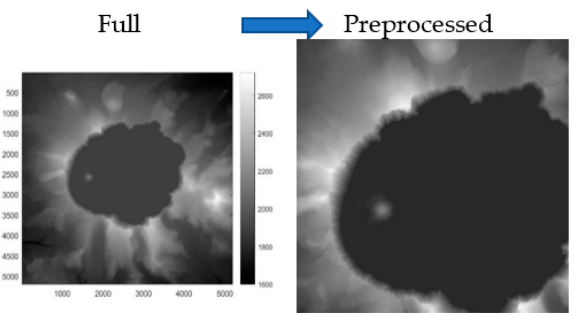
Figure 2. Volcanic caldera (Crater Lake, OR, USA) [64]: 1000 × 1000 with pixel size of 9.99 m.